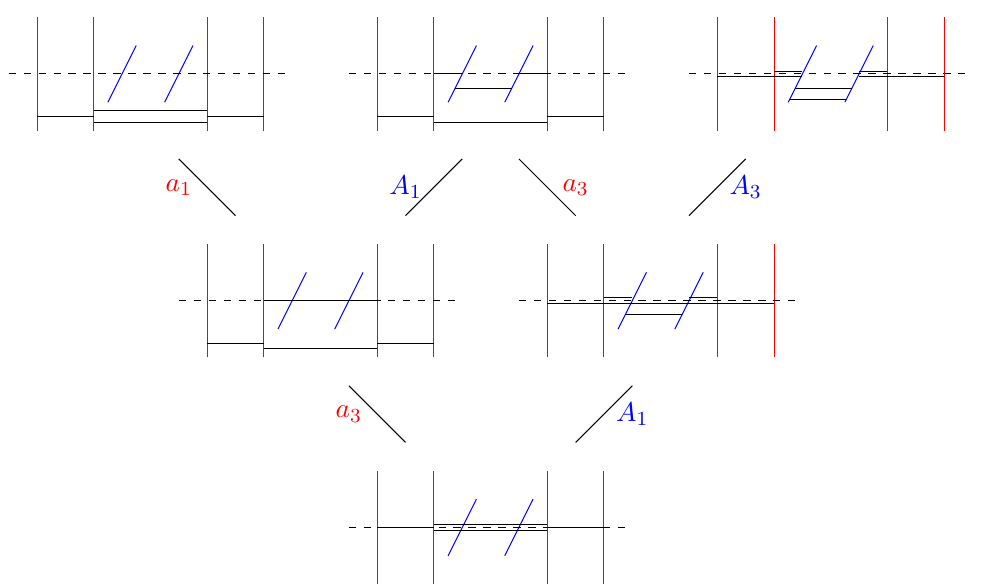
Figure 4 . Brane configurations corresponding to the leaves in (3.2). In [23] Hasse diagrams were computed moving along the top row. The commutativity of red and blue lines in the full Hasse diagram allows to construct the Hasse diagram of a single branch in this way. See the appendix